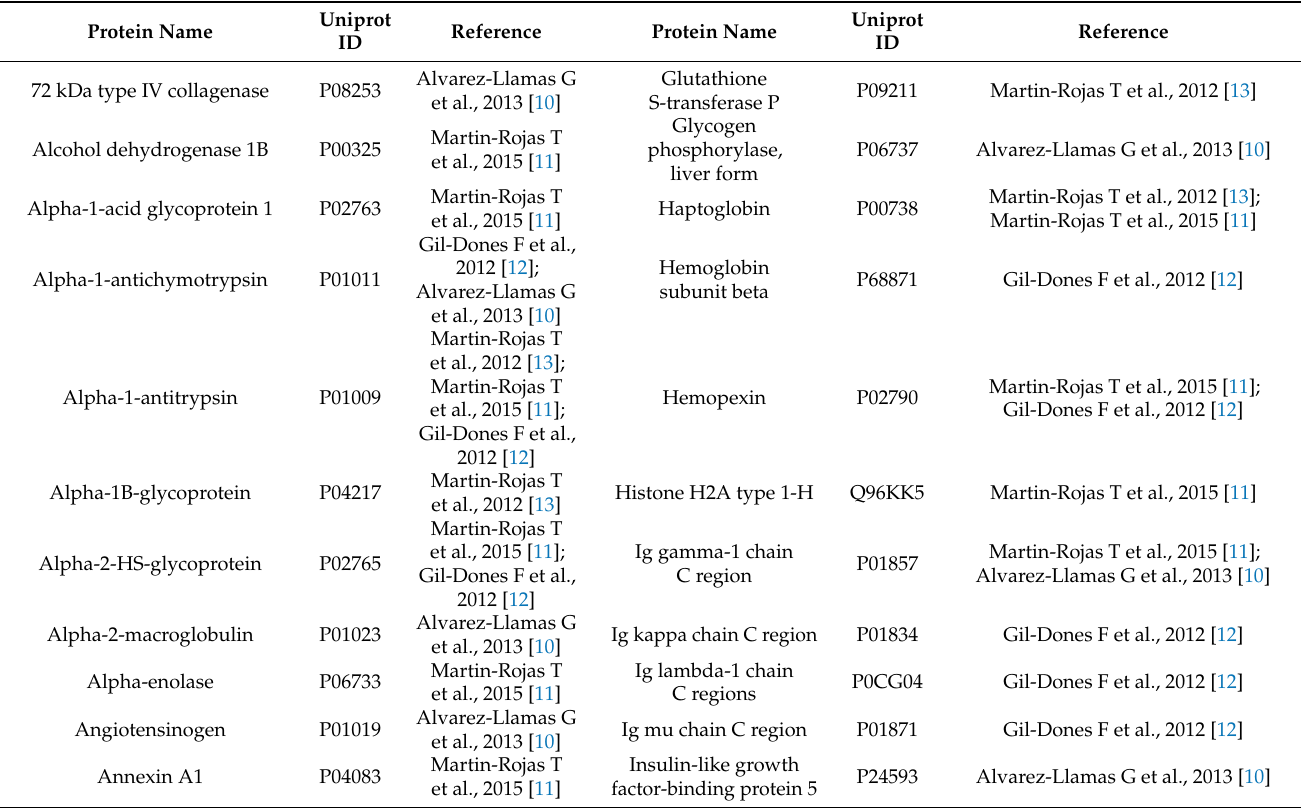
Table 1. List of 126 proteins of interest based on our previous studies, showing the original work used for the selection of each protein. Additional information about their biological functions is shown in Table S1. These proteins were subsequently evaluated using the ANN